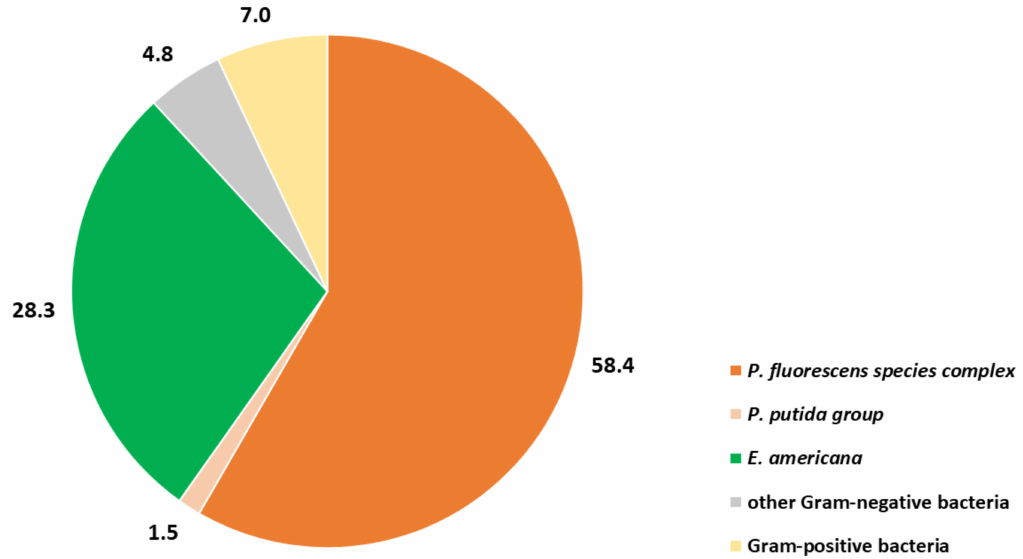
Figure 3. Percentage (%) of bacterial groups among isolates ( n = 413) originating from cultivated mushroom species.